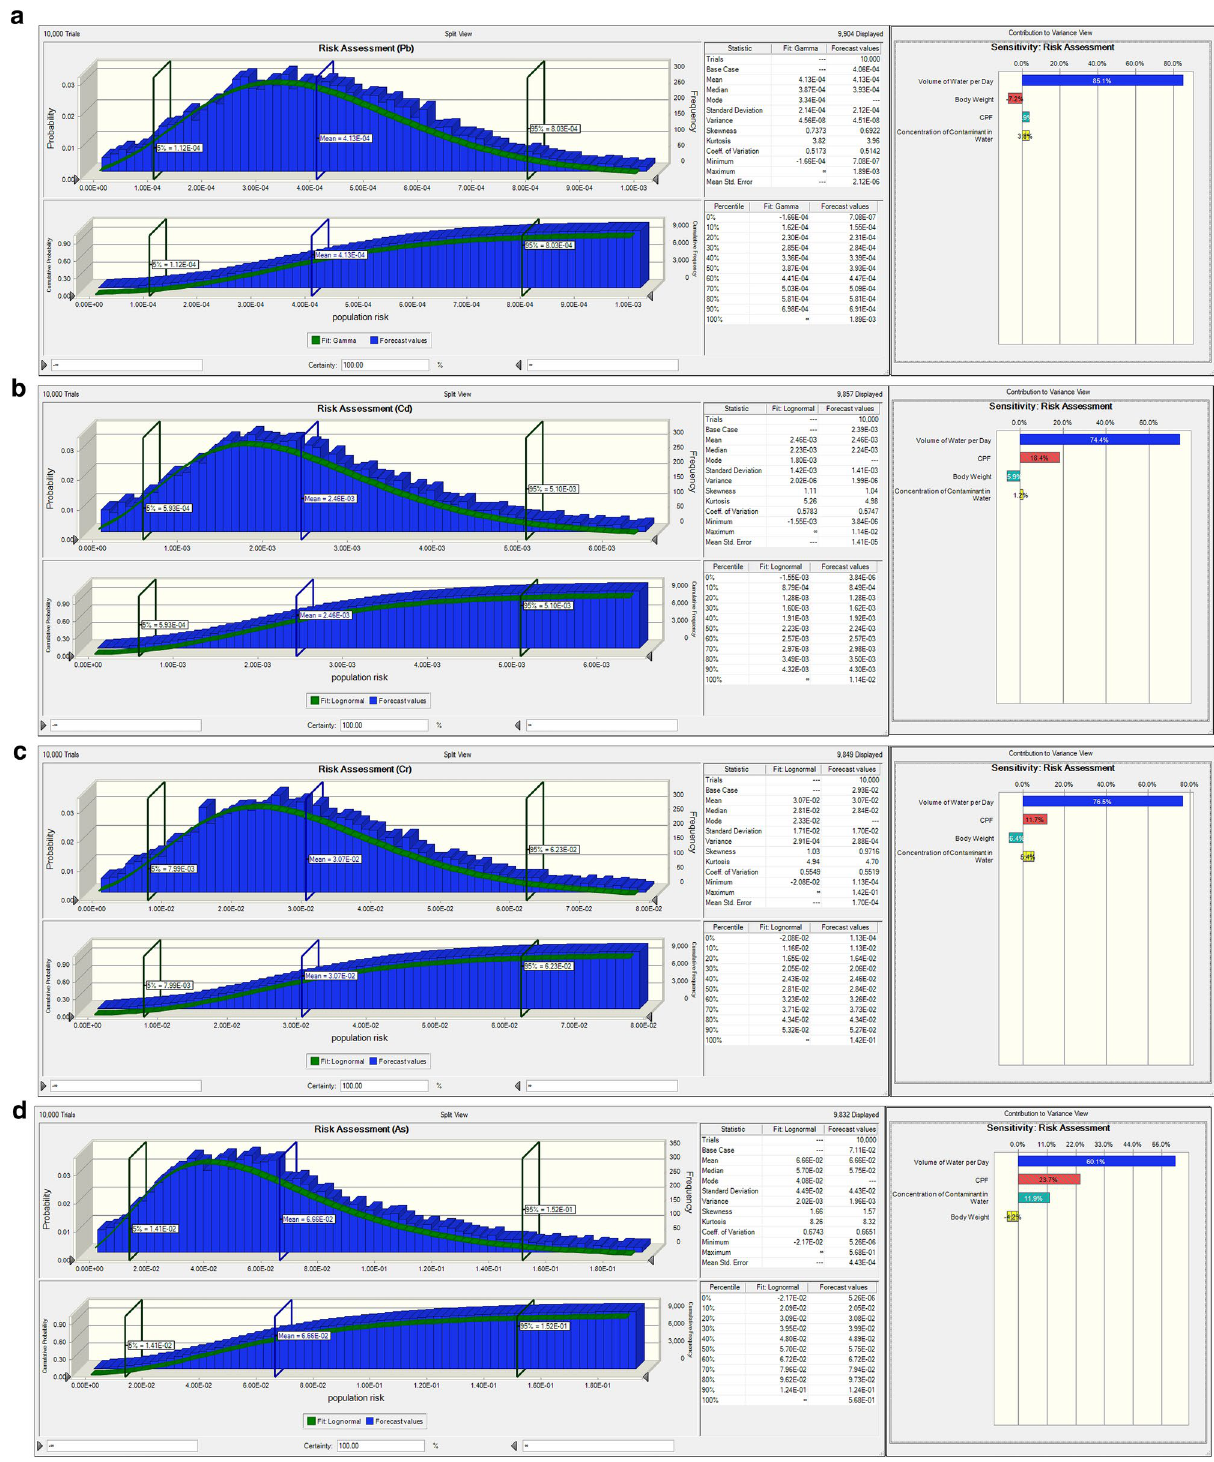
Figure 4. Cumulative probability plot of the Cancer risks for the water samples from the automobile spare part and recycling park: ( a ) Lead (Pb), ( b ) Cadmium (Cd), ( c ) Chromium (Cr) and ( d ) Arsenic